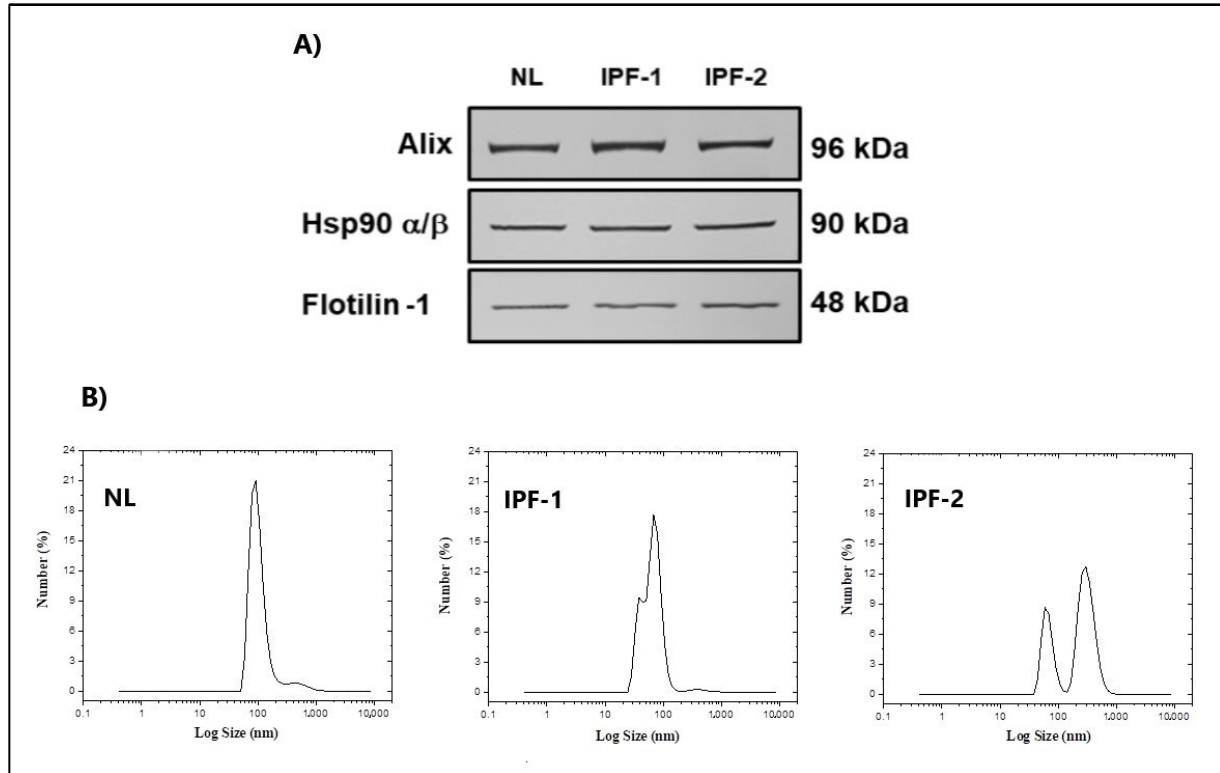
Figure 1. Validation of EVs from healthy and IPF lung fibroblasts. ( A ) Western blot EVs protein markers including ALIX, flotillin, and Hsp90. ( B ) Dynamic light scattering analysis of EVs for size terminations. Assays were performed in triplicate.